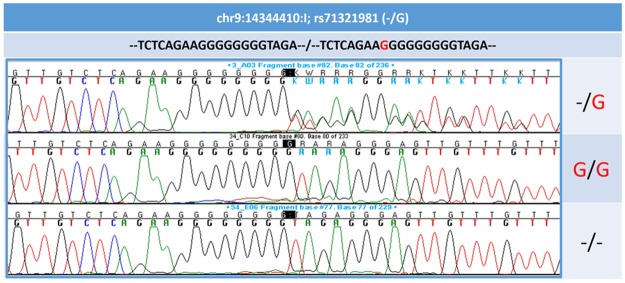
Sequence of the insertion chr9:14344410:I (rs71321981) within the regulatory region of the NFIB gene (9p22.3).The chr9:14344410:I (rs71321981) was sequenced in 184 individuals belonging to the YFS and 184 individuals included in the H2000 discovery cohort. Upper panel: heterozygous insertion/frameshift (-/G); Middle panel: homozygous insertion (G/G); Lower panel: wild type (-/-). The nucleotide sequences generated were compared to the reference sequence at 1000 Genomes browser (see URLs).